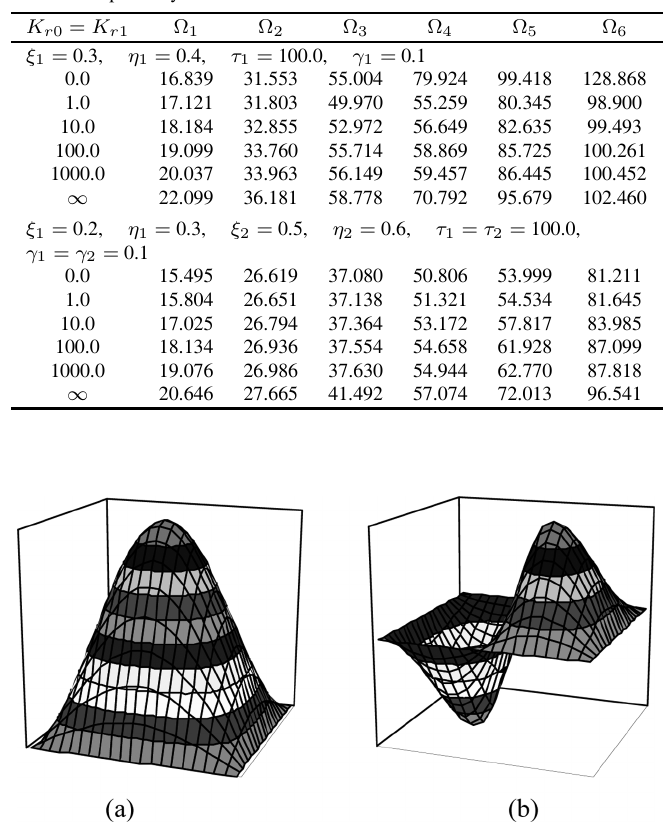
Table 5 The fi rstsixeigenfrequenciesofcoupledvibrationforasimplysupportedsquare